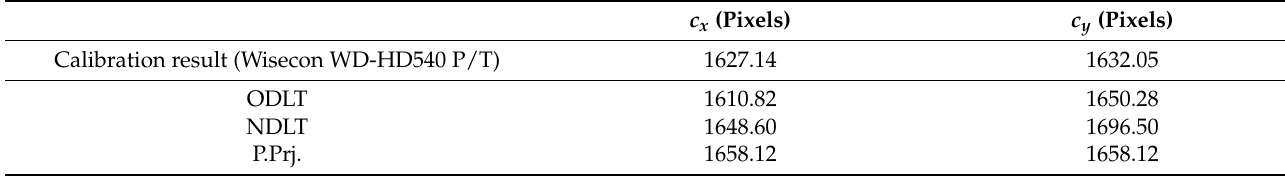
Table 4. Calibration result and estimated principal distance of CCTV.